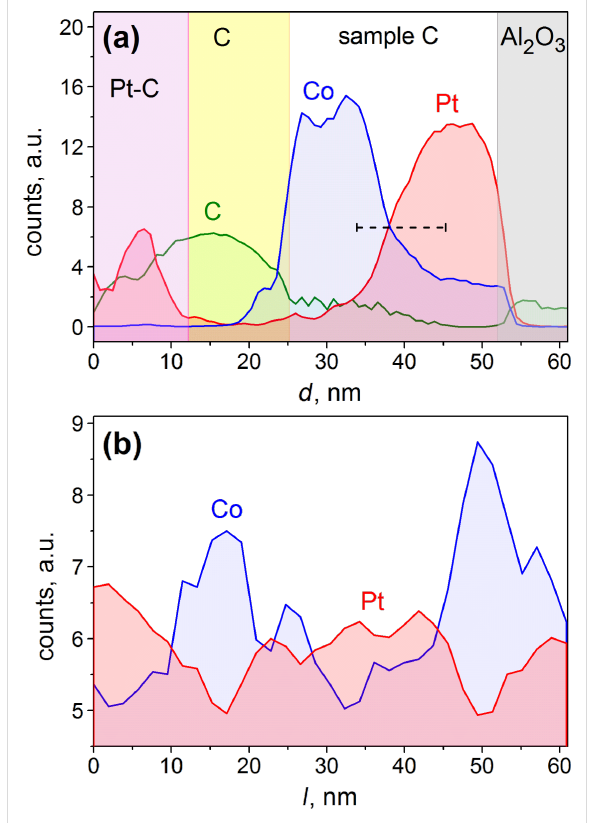
Figure 6: (a) Cross-sectional and (b) lower layer in-plane EDX elemental peak intensities for sample C acquired along the respective arrows in Figure 5. The dashed line in (a) sketches the choice of the thickness of the control sample D where the CoPt L1 0 phase is expected to be formed over nearly the entire sample